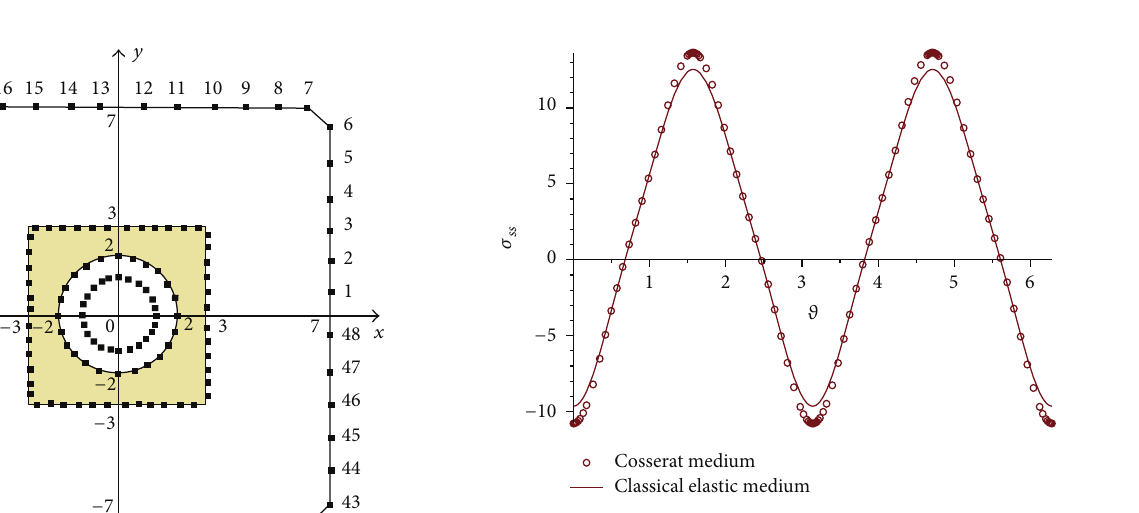
Figure 7: Graphs of the distribution of stress 𝜎 𝑠𝑠 along the hole contour for the classical elastic medium and the Cosserat medium for domain Ω 1 .